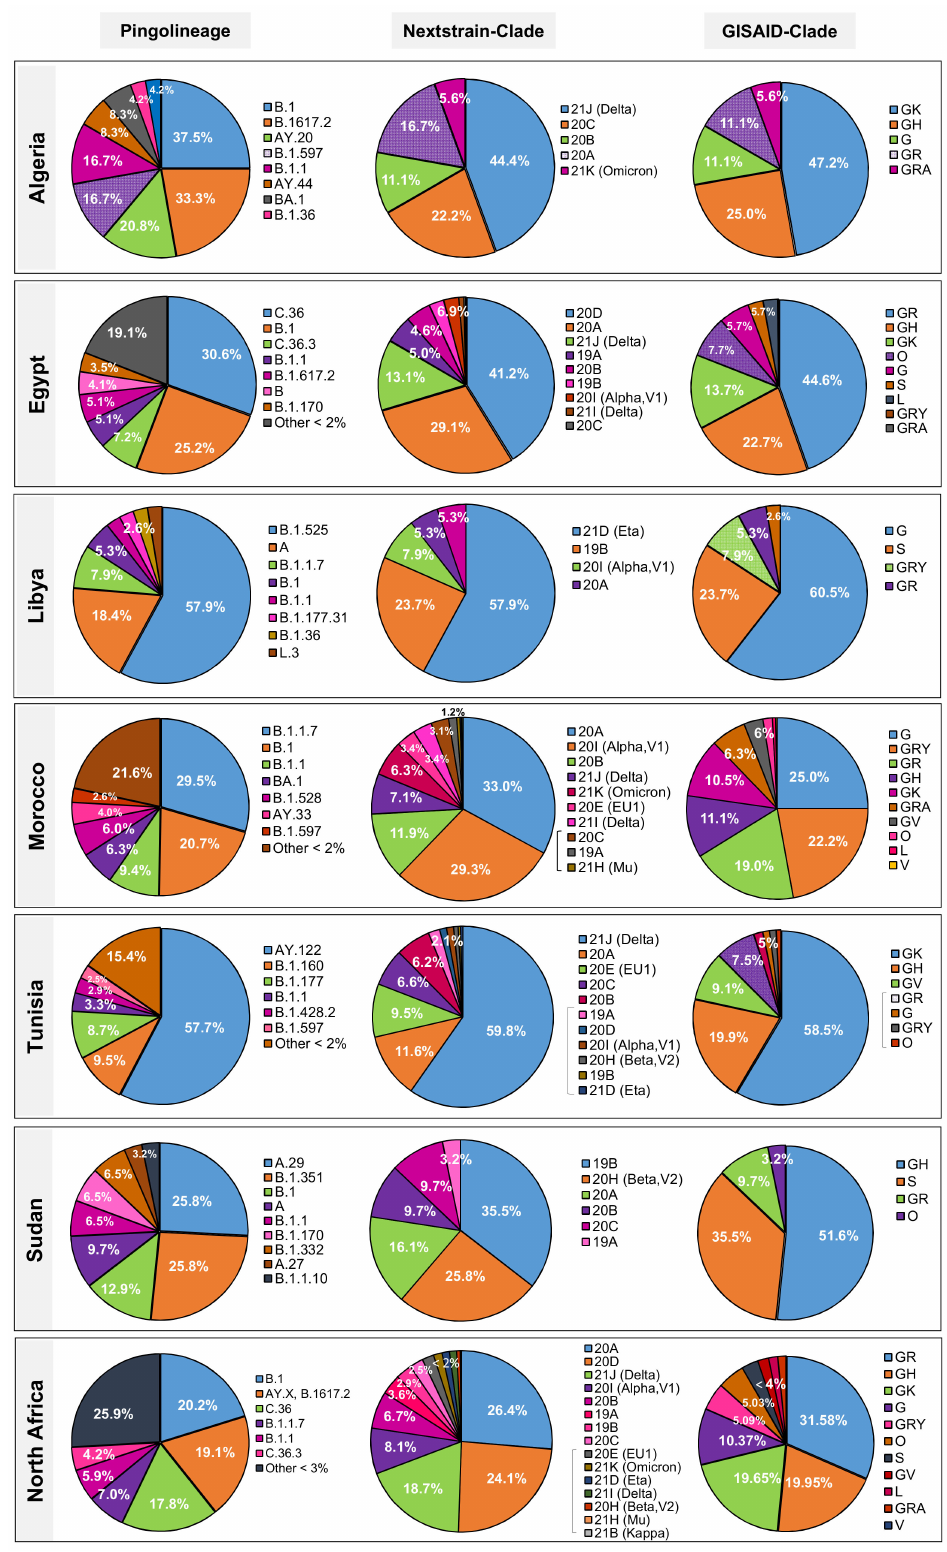
Figure 3. Distribution of various SARS-CoV-2 clades and lineages from Algeria and North African